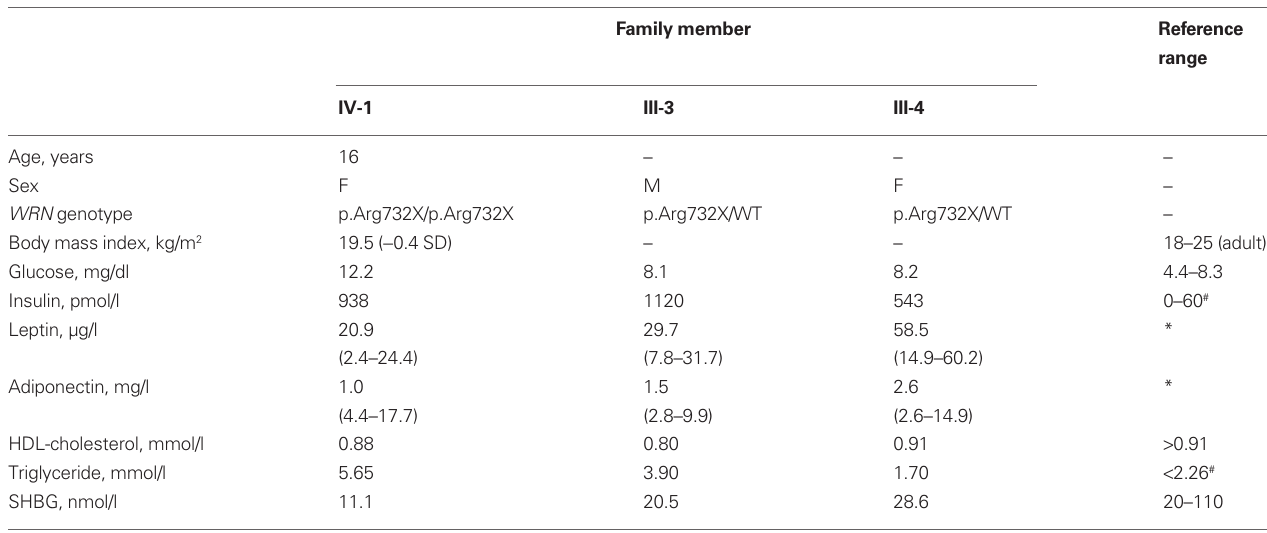
Table 1 | Biochemical profile of proband and parents (postprandial).